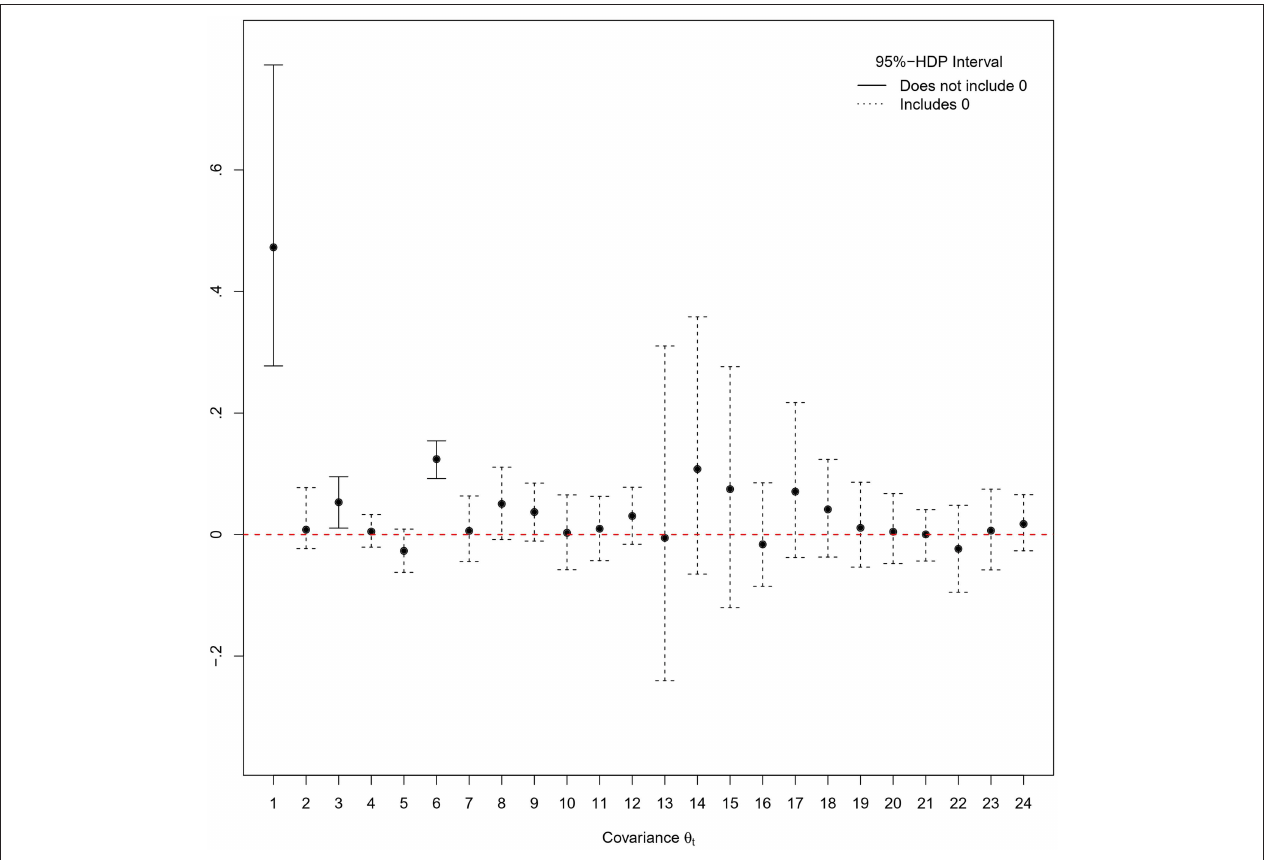
FIGURE 3 | 95%-Highest Posterior Density (HPD) intervals for the N t = 24 covariance parameters in the additive covariance structure. Black dots correspond to posterior mean